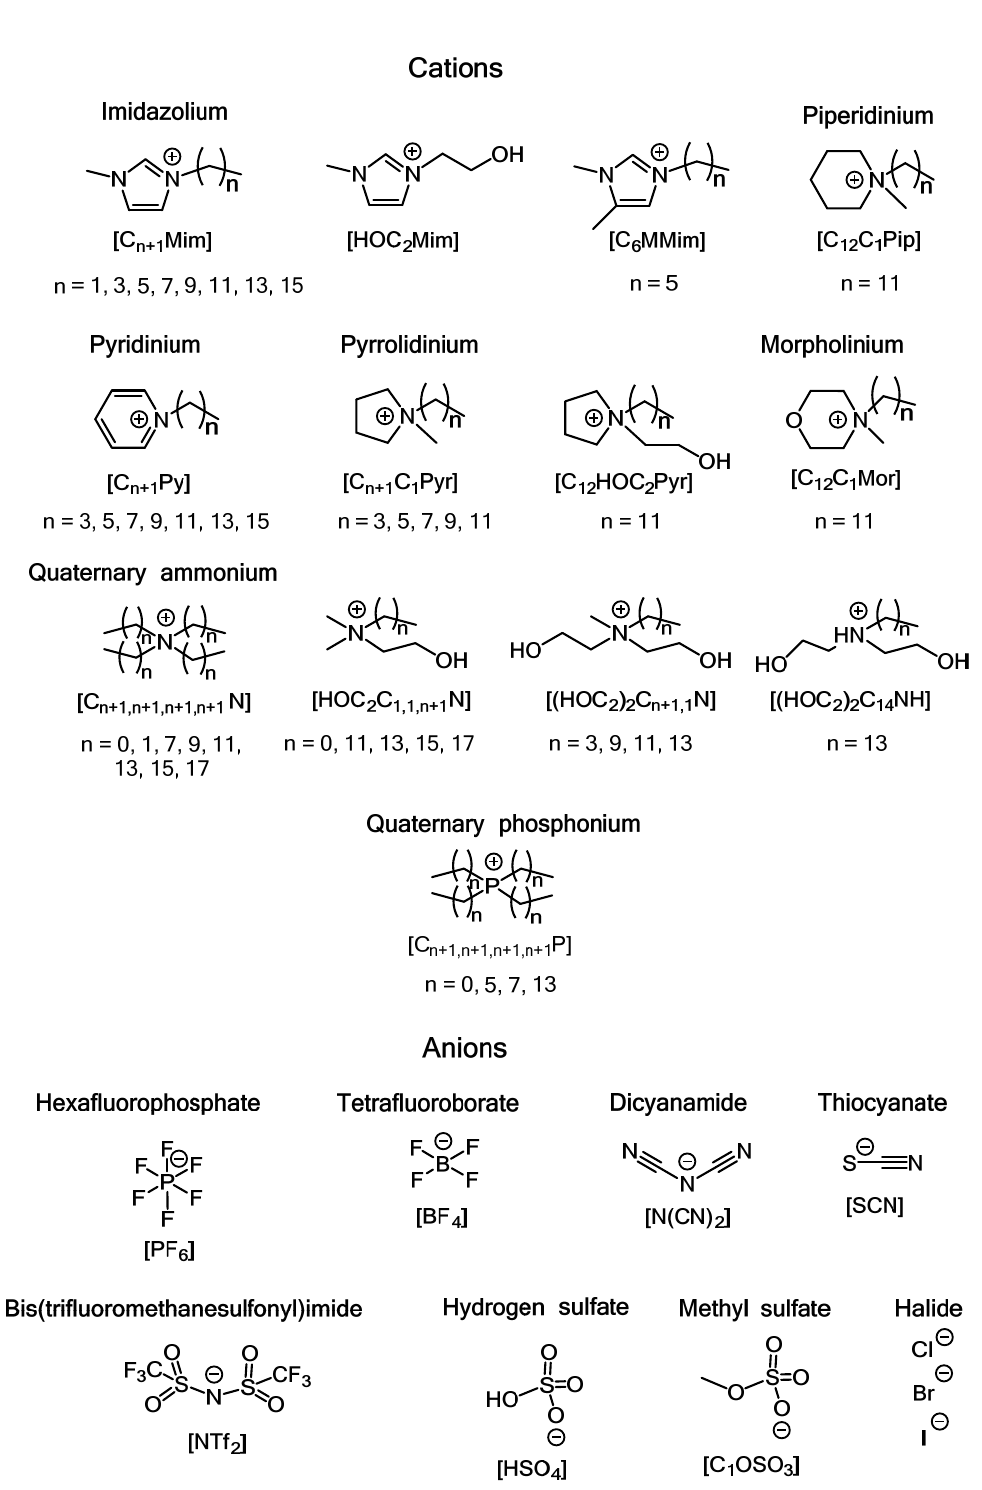
Figure 18. Cations and anions commonly used in ILs with known antimicrobial activity.